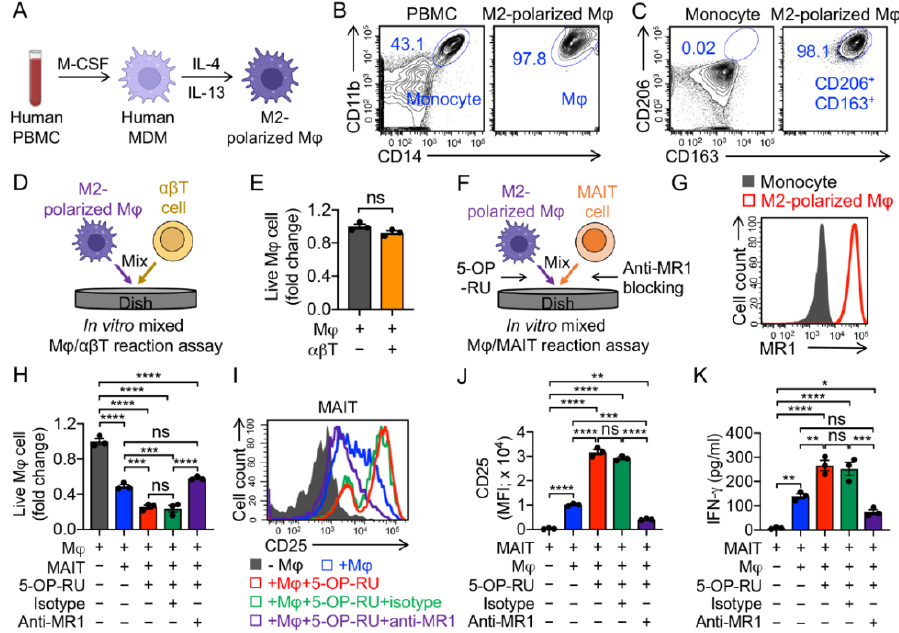
Figure 3. In vitro targeting of immunosuppressive macrophages by PBMC-derived MAIT cells. ( A – C ) In vitro generation and polarization of human monocyte-derived M2 macrophages. ( A ) Experi- mental design. M-CSF, macrophage colony-stimulating factor; MDM, monocyte-derived macrophage; M ϕ , macrophage. ( B ) FACS detection of CD11b and CD14 on M2-polarized macrophages.